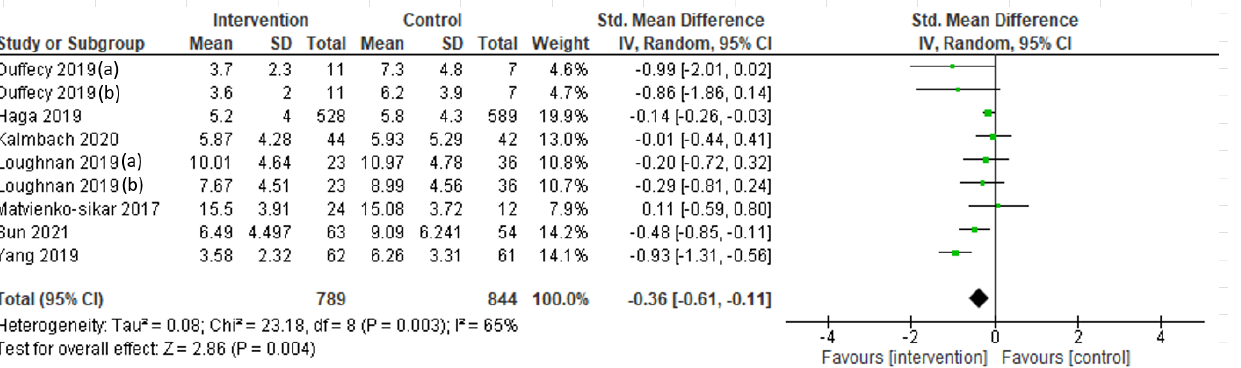
Figure 2. Depressive symptoms at the endpoint: Duffecy 2019 (a, [64]) = PHQ-9; Duffecy 2019 (b, [64]) = HARS; Loughnan 2019 (a, [67]) = EPDS; Loughnan 2019 (b, [67]) = PHQ-9.